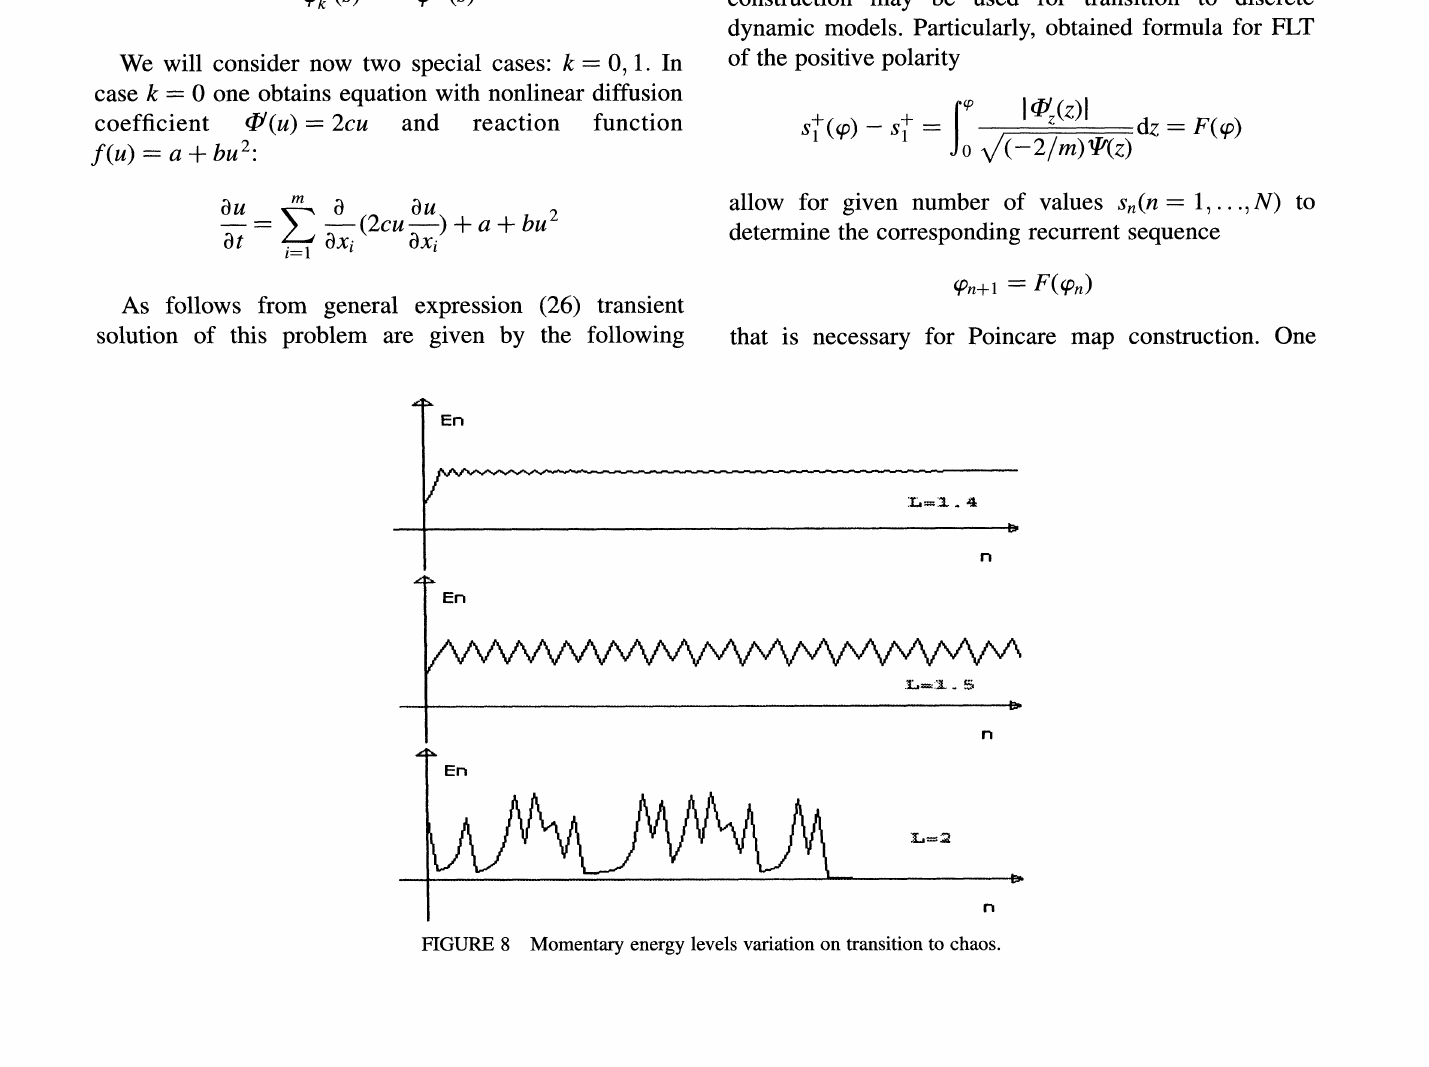
FIGURE 8 Momentary energy levels variation on transition to